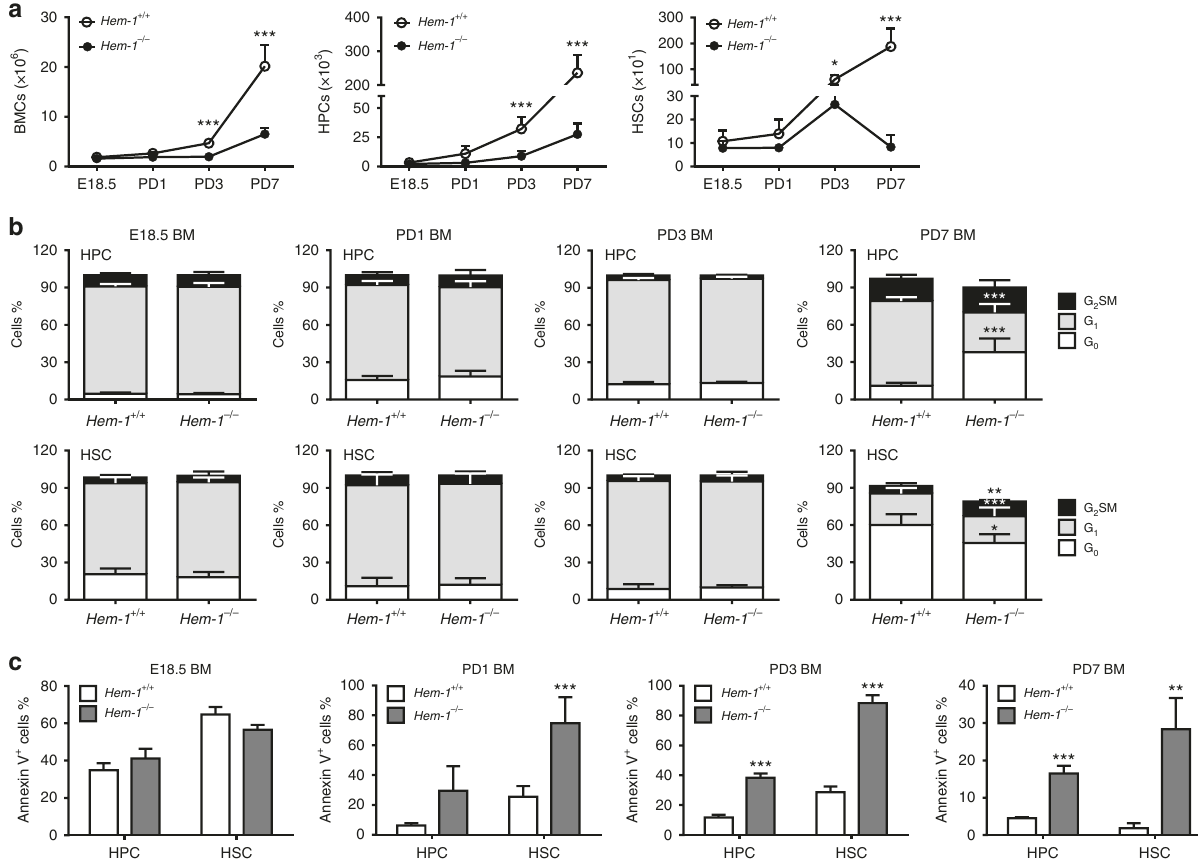
Fig. 4 Hem- 1 deletion results in a progressive decrease of HSCs mediated by increased apoptosis. a Hem-1 deletion leads to the loss of HPCs and HSCs in a developmentally dependent manner. BM cells were harvested at E18.5, postnatal day (PD) 1, 3, and 7, and total BM cells (BMCs), HPCs, and HSCs were determined ( n = 5, * p < 0.05, *** p < 0.001, one-way ANOVA). b HPCs and HSCs from Hem-1 − / − mice showed no signi fi cant difference in cell cycle distribution except PD7 compared to the cells from littermate controls ( n = 5, ** p < 0.01, *** p < 0.001, χ 2 test). c Hem-1 − / − HPCs and HSCs had progressive increases in the fraction of apoptosis as measured by Annexin V staining compared to littermate controls ( n = 5, ** p < 0.01, *** p <